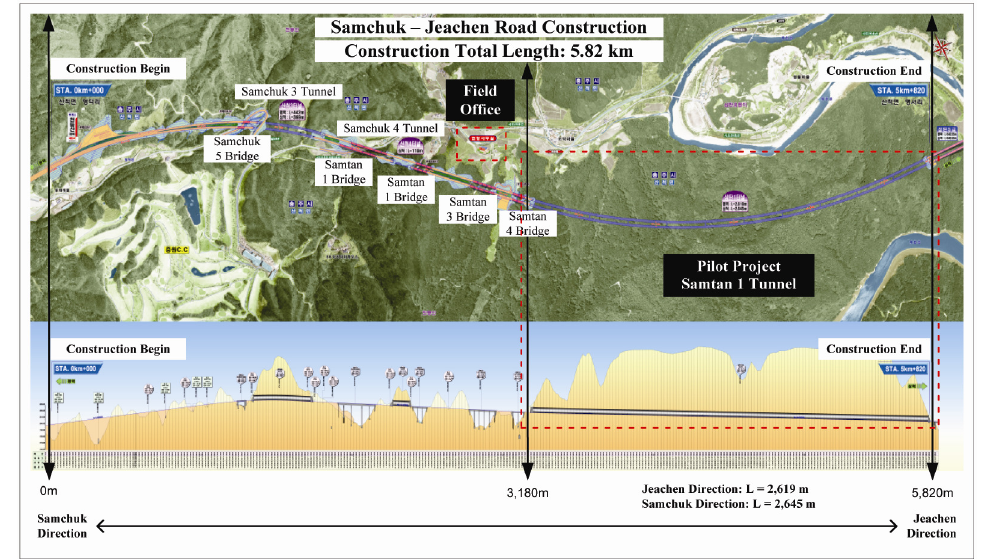
Fig. 6. Prototypical longitudinal profile of Samchuk–Jeachen Road